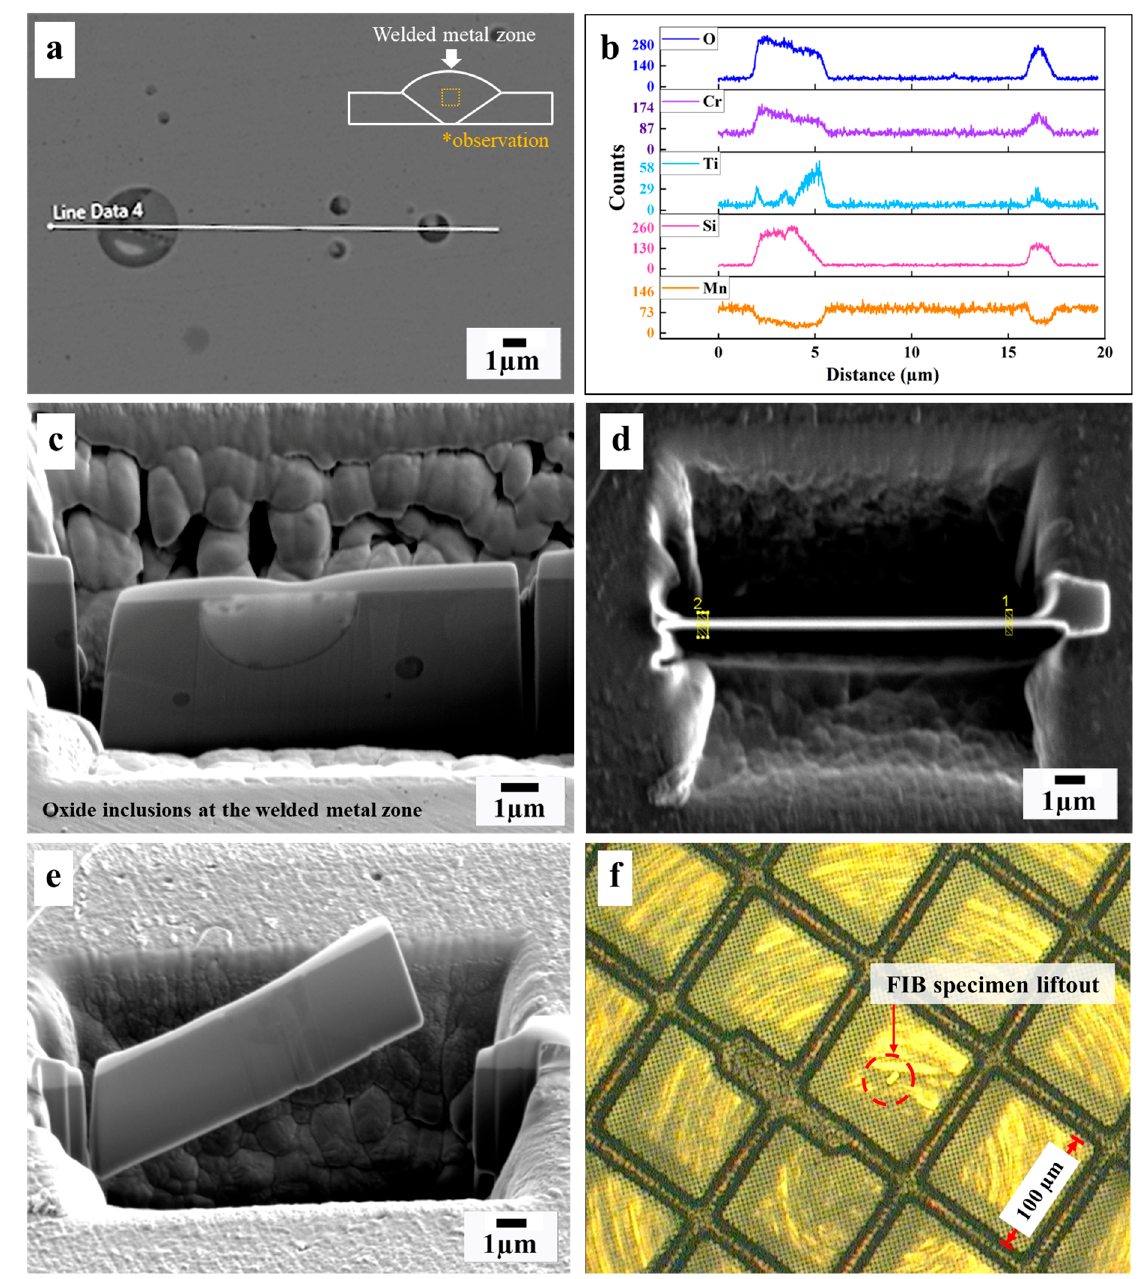
Figure 7. Schematic showing the cross-sectional positions of the welded metal zone after ( a ) SEM; ( b ) line scanning on the oxide inclusions; ( c – e ) oxide inclusions cut off by FIB; ( d ) sequence of cutting (1, 2); ( f ) specimen lift-out and adhesive on the copper grid.